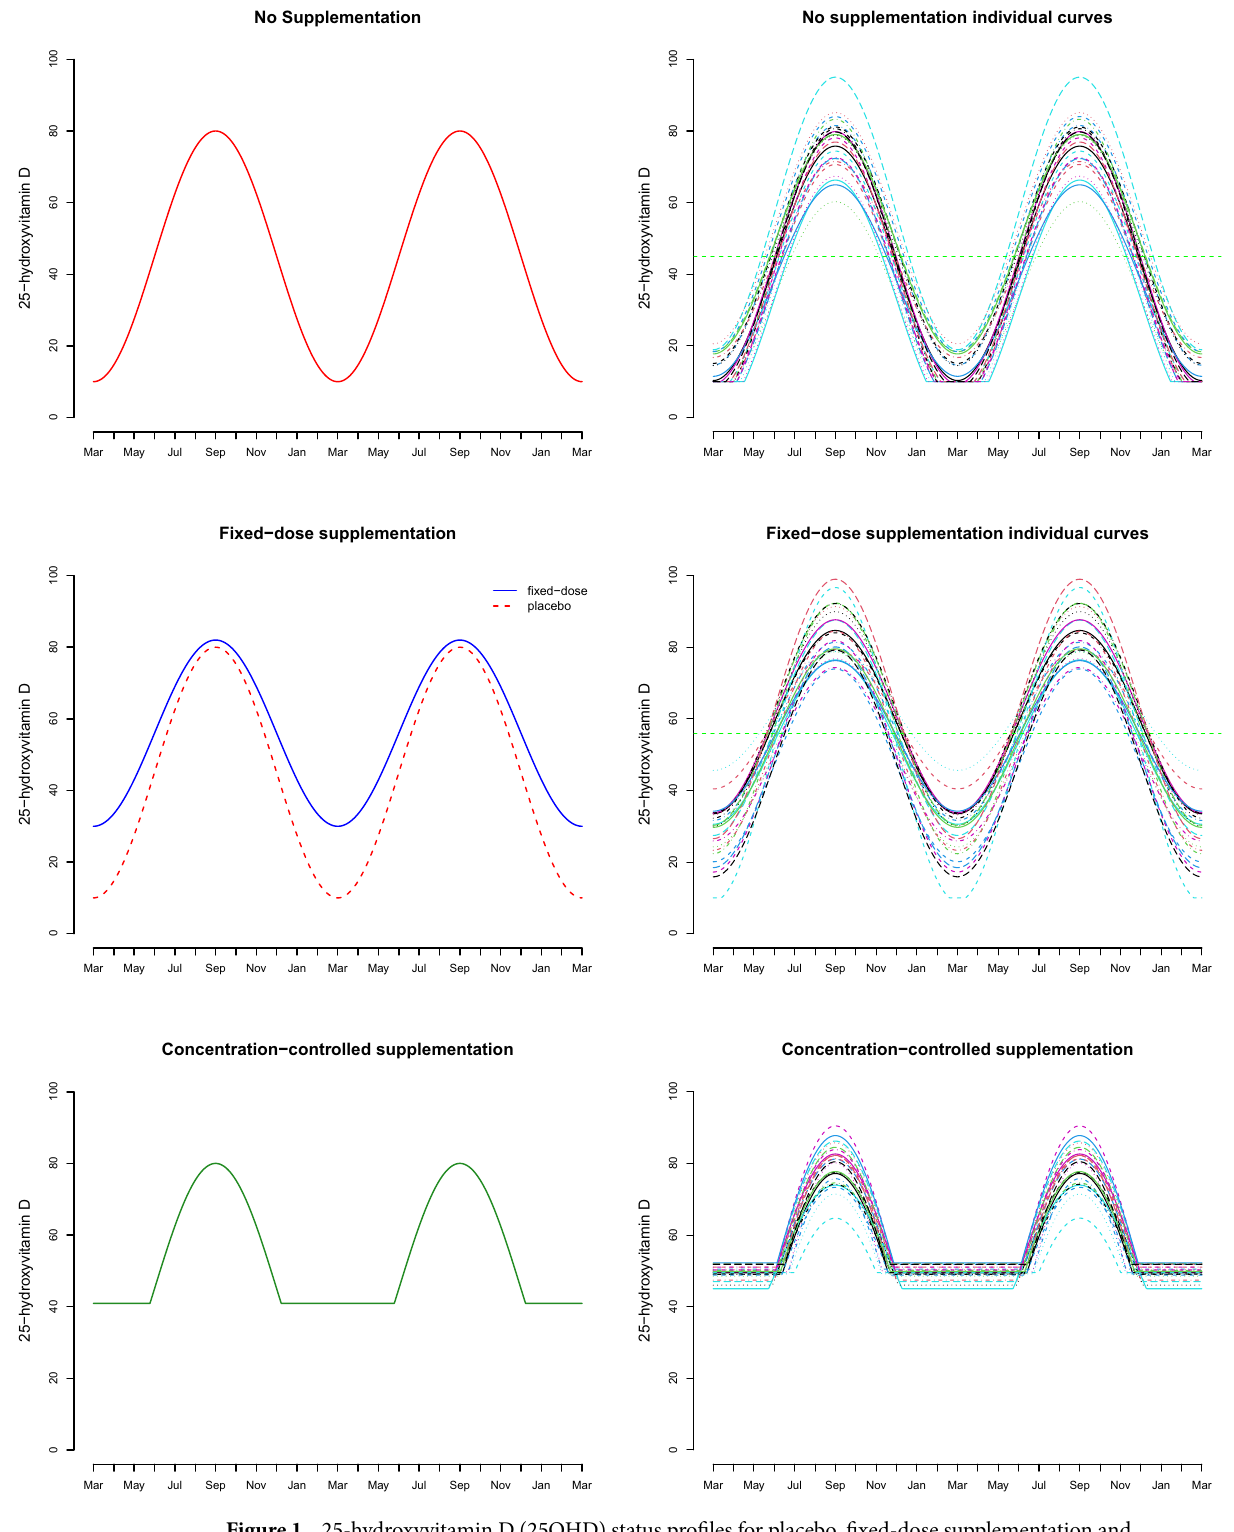
Figure 1. 25-hydroxyvitamin D (25OHD) status profiles for placebo, fixed-dose supplementation and concentration-controlled intervention schemes. The middle panel on the left compares the fixed-dose scheme with more uptake during deficient periods. Horizontal green dashed lines in the top two panels indicate effective overall mean levels of 25OHD assumed in the